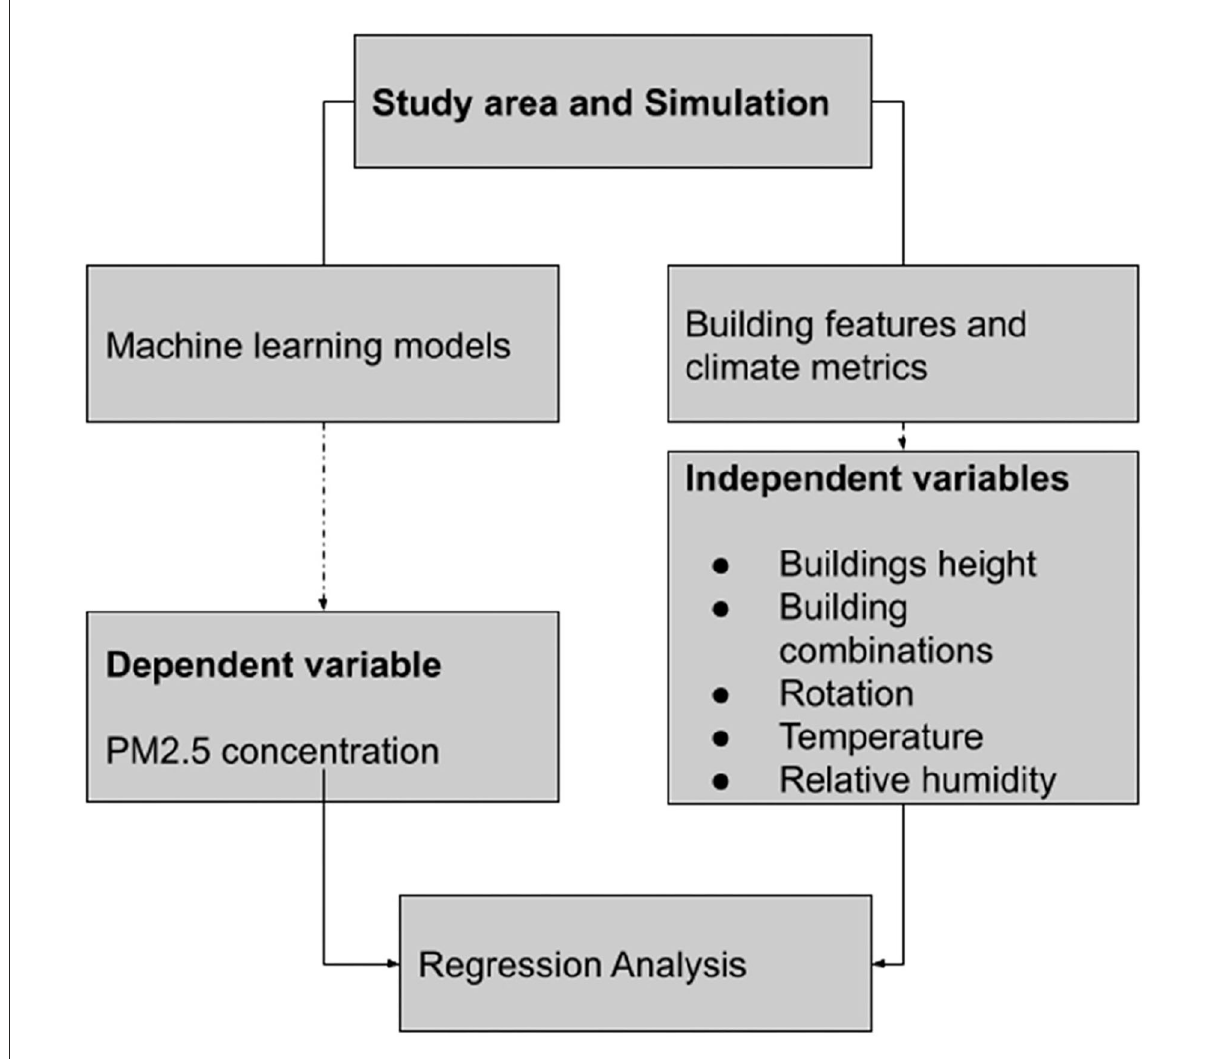
FIGURE1 Research